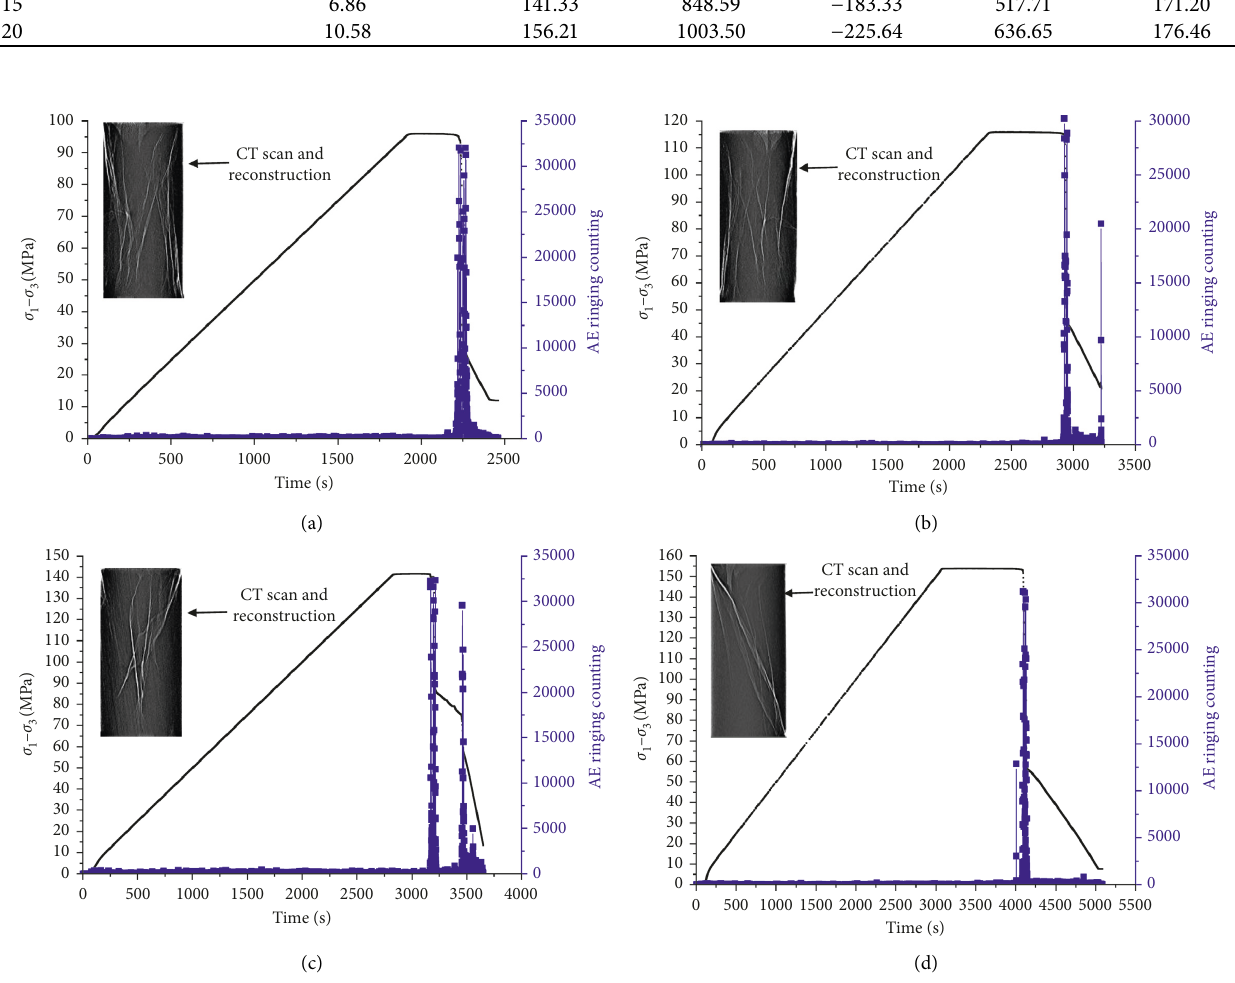
Figure 5: Test results of AE ringing counts of rock specimens under unloading confining pressure. (a) The initial value σ